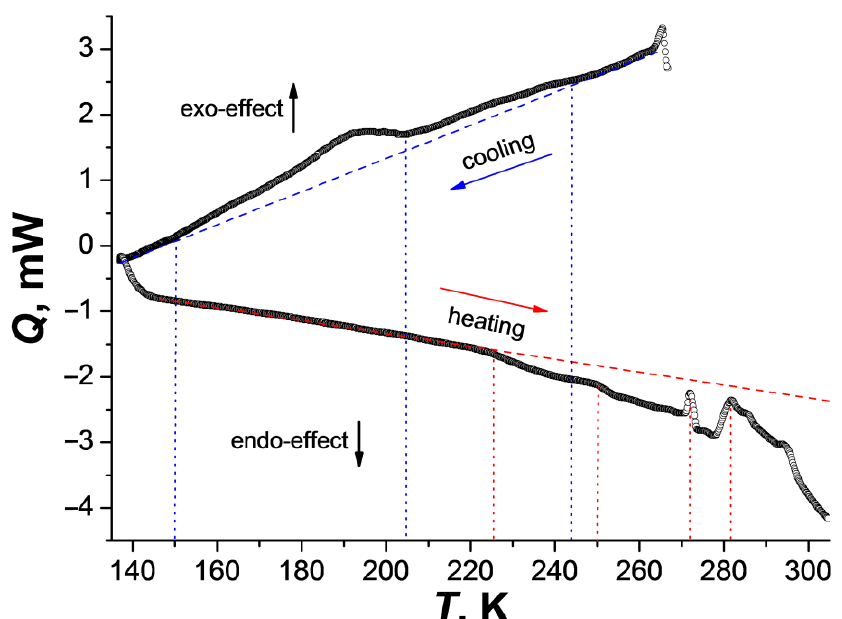
Figure 1. Changes in the heat flux during cooling (270–135 K) and heating (135–300 K) of complex 1 (temperature rate is 10 K/min; dotted lines correspond to the deviations of the curves from the baseline (dashed lines) and the beginning of the anomaly).